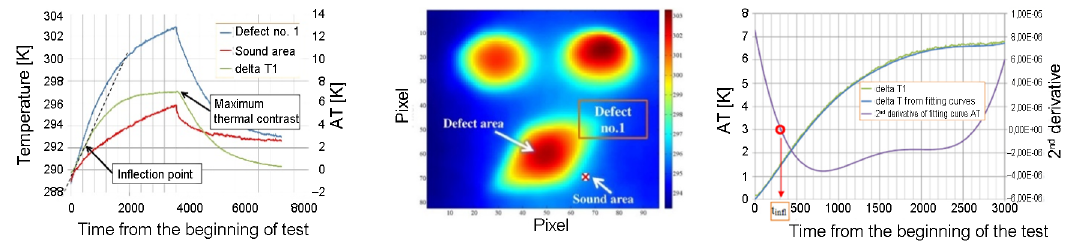
Fig. 17. Temperature evolution curves, bottom side, specimen BM 2-3, distance 2 m